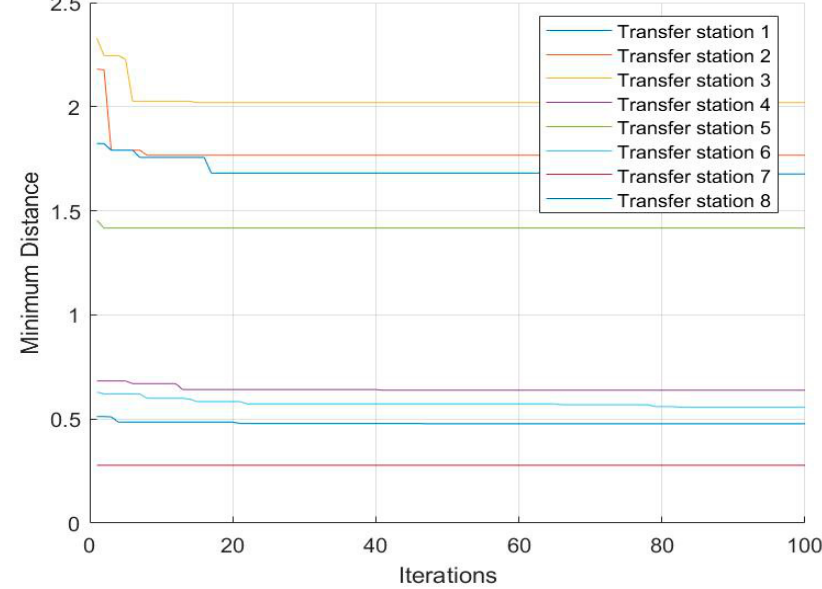
Figure 8. The convergence of each transit path with the increase of iteration times.